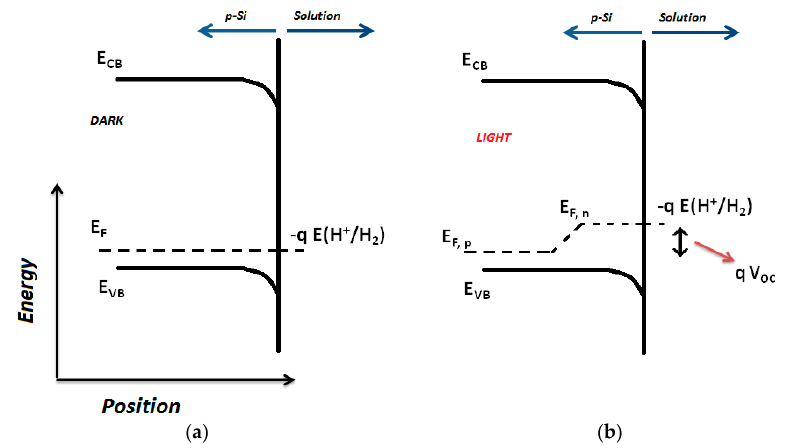
Figure 19. Bending of the energy levels at the interface p ‐ Si/electrolyte in presence of the redox couple H + /H 2 at the redox potential E(H + /H 2 ). The depiction is given in both dark conditions ( a ), and under illumination ( b ). E F represents the Fermi level of p ‐ Si semiconductor. Symbols E F, p and E F, n refer to the quasi Fermi levels of the holes and electrons, respectively, when the interface is under illumination. Adapted from reference [126]. Table 5. Si based p ‐ type semiconducting electrodes, photoelectrocatalytic agents and conditions of photoelectrolysis for H 2 production from water splitting.